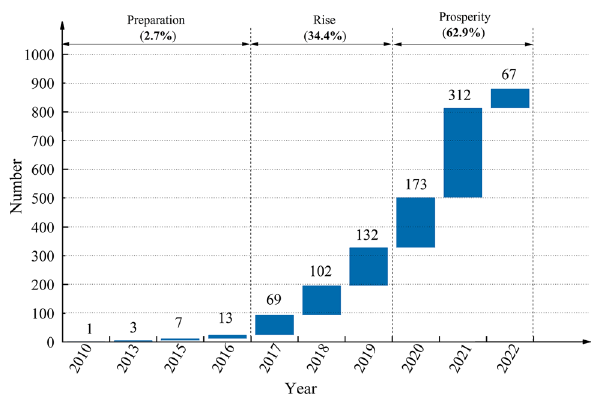
Fig. 4 Changes in the number of MMDLM publications from 2010 to 2022